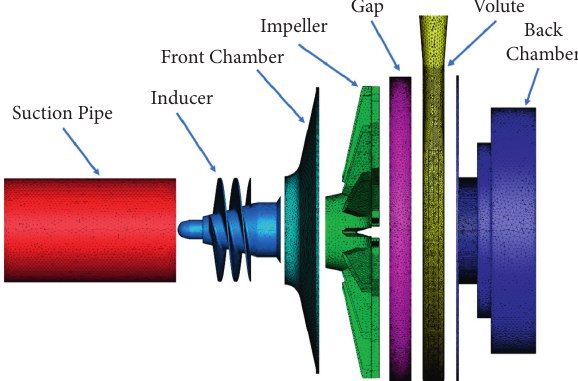
Figure 1: Computational domain and mesh of each